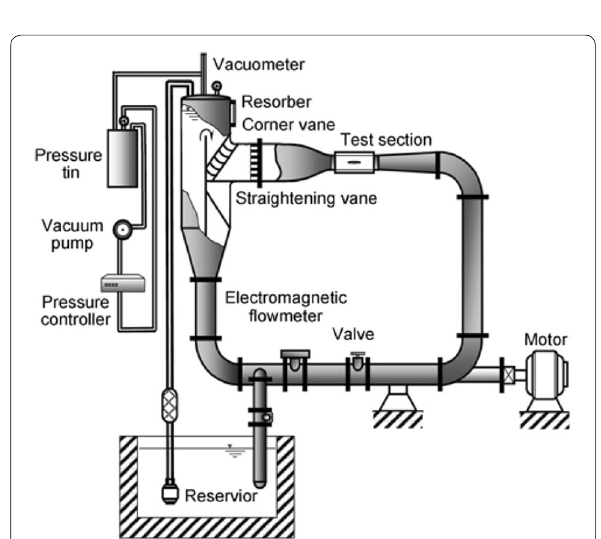
Figure 1 Sketch map of cavitation